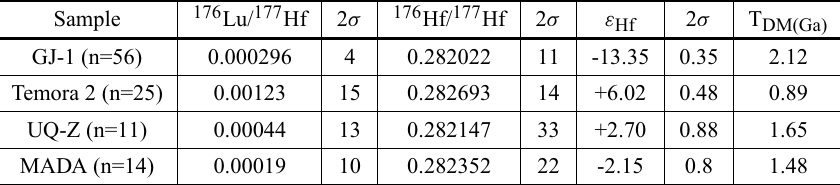
Mean Hf isotopic compositions for zircon standards obtained by